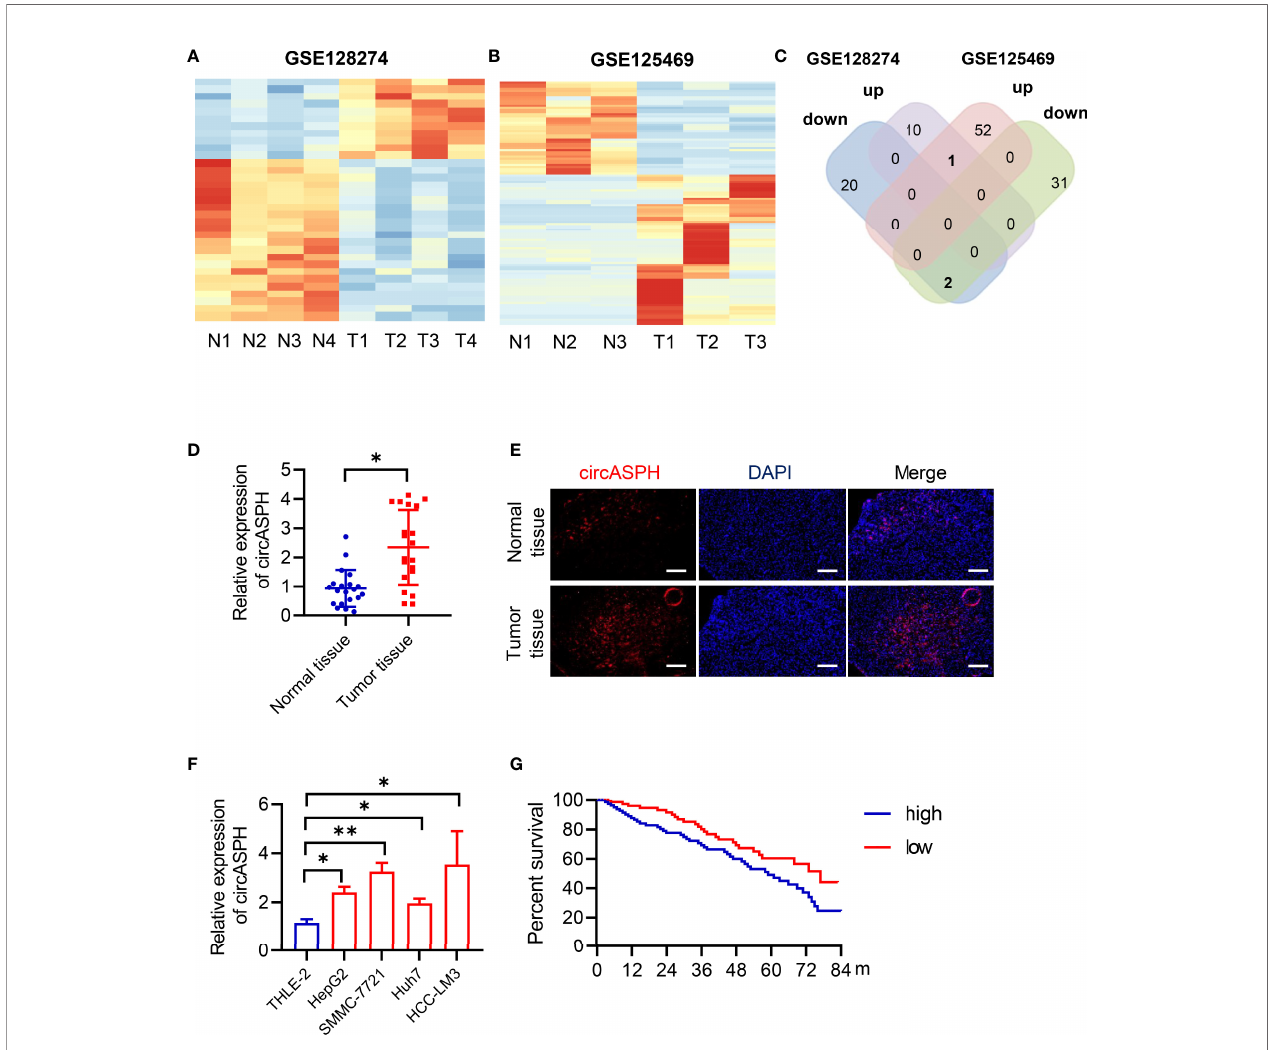
FIGURE 1 | CircASPH expression was identi fi ed to be signi fi cantly upregulated in HCC tissues and related to patient prognosis. (A, B) Heat maps of differentially expressed circRNAs in HCC tissues and non-tumor tissues obtained from GSE128274 and GSE125469. (C) The numbers of overlapping differentially expressed circRNAs from two GEO databases are shown in the Venn diagram. (D) The level of circASPH expression was evaluated by RT-qPCR in 20 paired HCC tissues and normal tissues. (E) FISH analysis of the expression of circASPH in HCC tissues and normal tissues. (F) CircASPH expression in HCC cell lines compared with THLE- 2 cells. (G) Kaplan – Meier analysis showed that the level of circASPH was predictive of overall survival. *p < 0.05, **p <